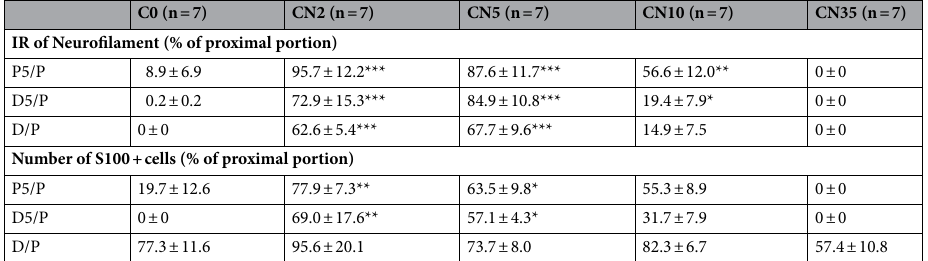
Table 3. Immunohistochemical evaluation of axonal outgrowth and number of S100 positive cells in the matrix and in the distal nerve segment of rat sciatic nerve defects, bridged by different densities of carbon nanotube yarn in 8 weeks after the transplantation. IR immunoreactivity, P proximal nerve end, P5 5 mm from the proximal stump, D5 5 mm from the distal stump, D distal nerve end. *P < 0.05, ** P < 0.01, *** P < 0.001 (One-tailed ANOVA with Tukey–Kramer test compared with